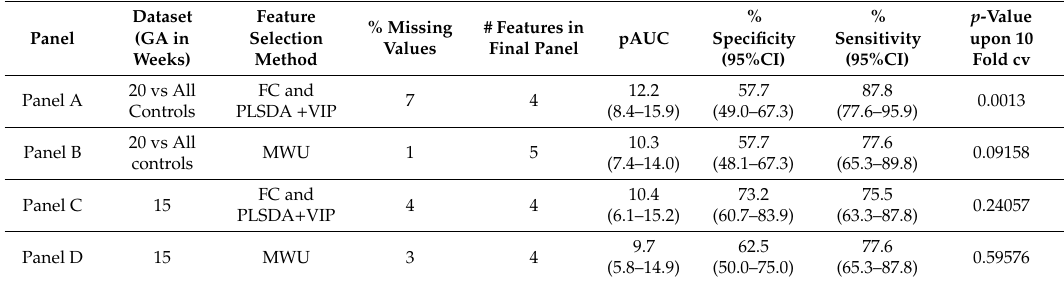
Table 3. PanelomiX Results